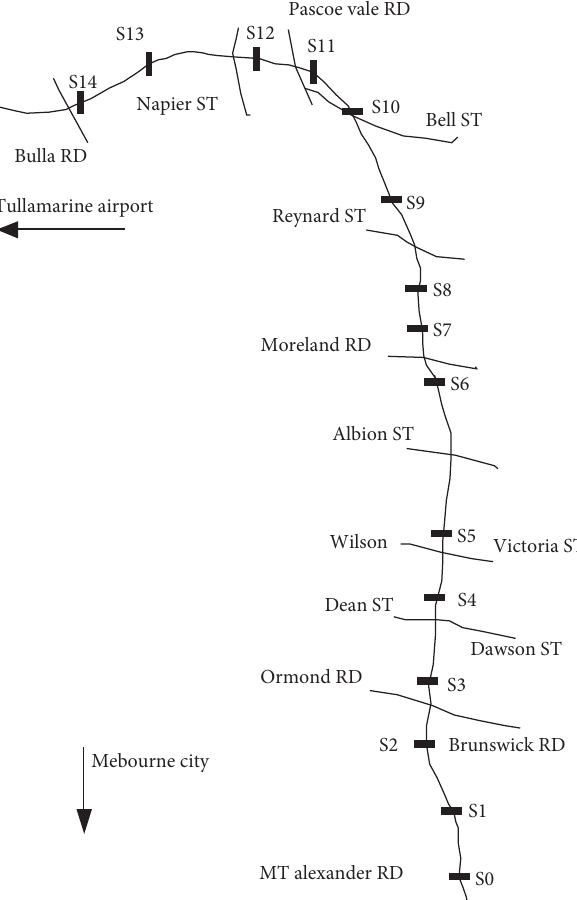
Figure 2: Schematic diagram of the Tullamarine Freeway used for collecting dataset 2